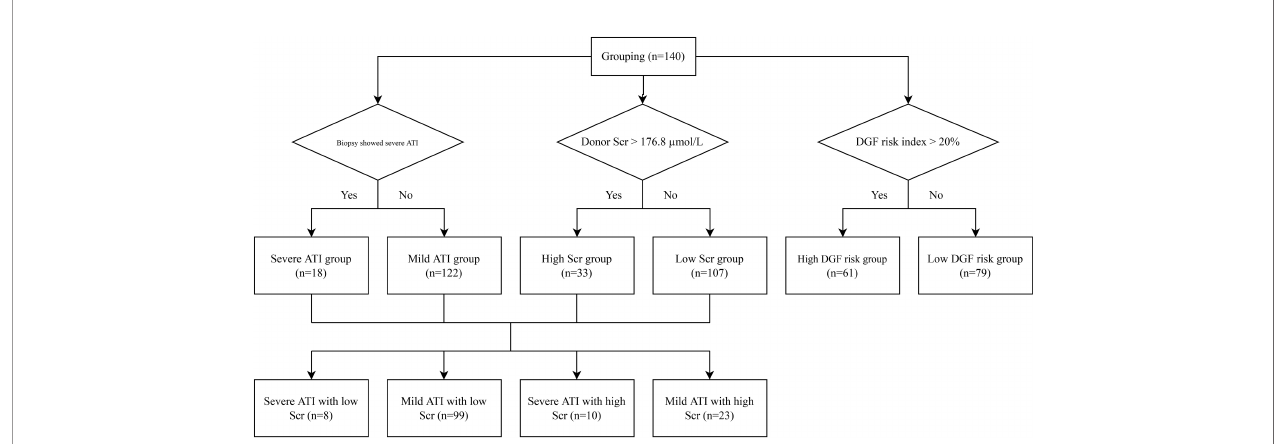
FIGURE 1 | Grouping fl owchart. ATI, acute tubular injury; Scr, serum creatinine; DGF, delayed graft